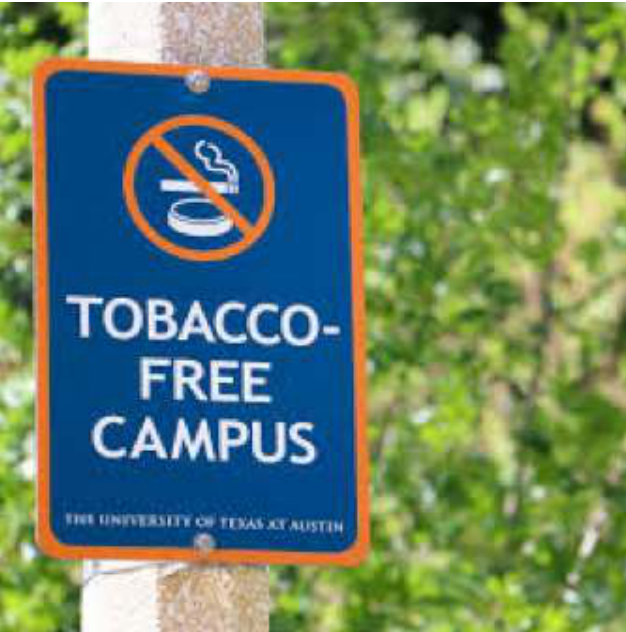
Figure 4: Tobacco-Free Campus